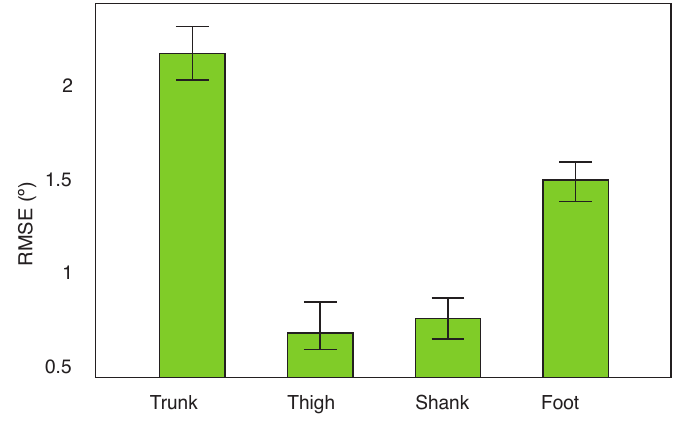
Figure 6. Main effect of segment. The bars represent the 95% confidence